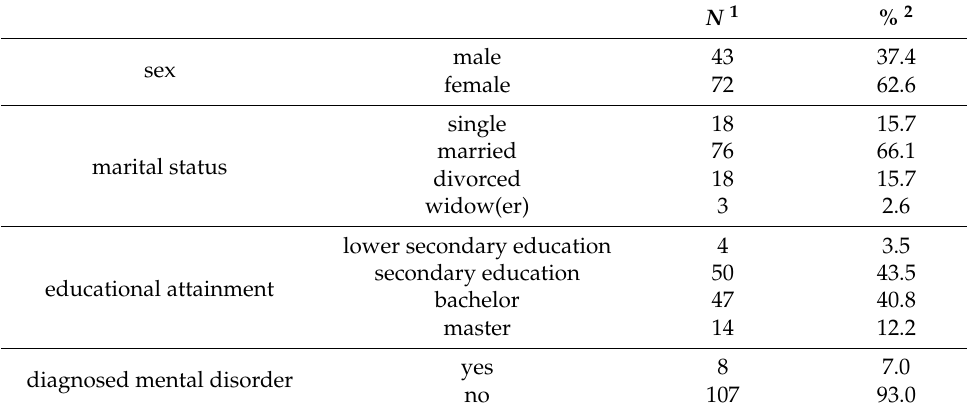
Table 1. Characteristics of the study